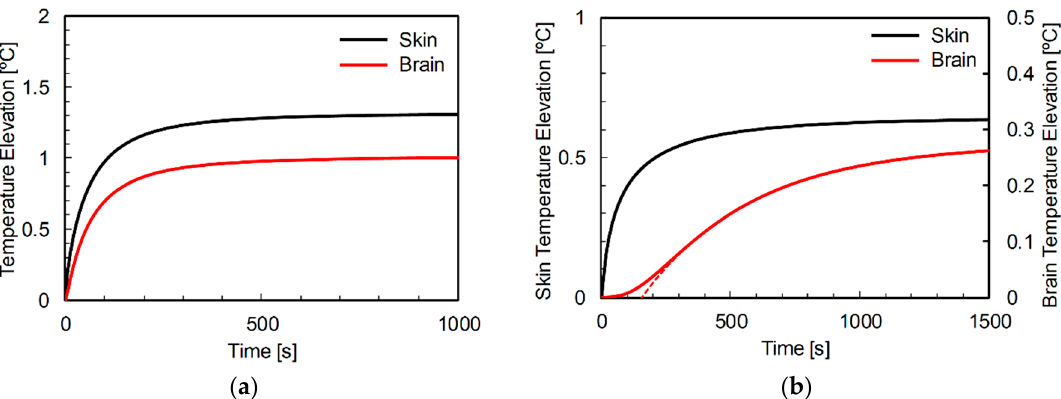
Figure 6. Time evolution of temperature elevation in the ( a ) rat and ( b ) TARO models at 10 GHz. The SAR averaged over 10-g tissue was adjusted to 2 W/kg. The distances from the antenna to the head were ( a ) 5 mm and ( b ) 25 mm. The dotted line in ( b ) shows the regression curve from Equation (9).